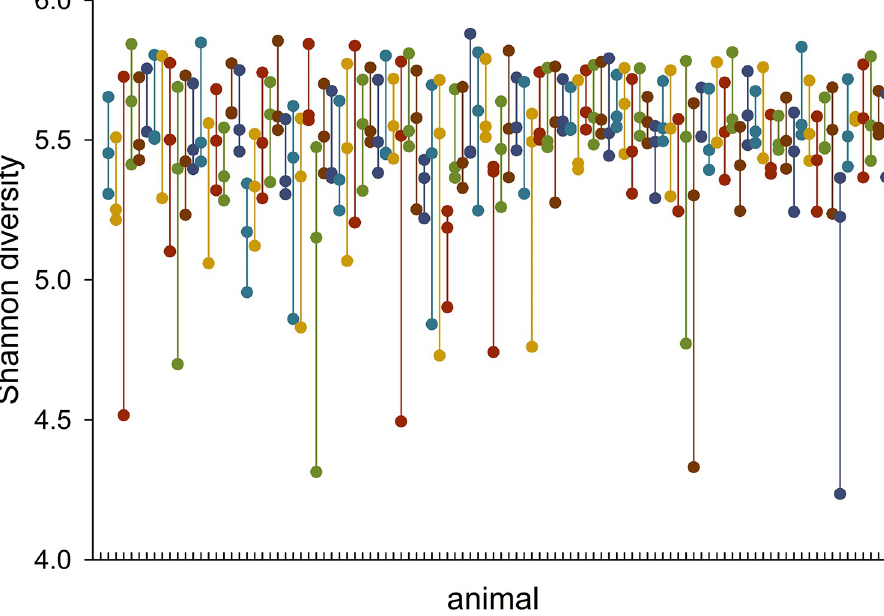
Fig 2. Persistence of low- and high-diversity microbiota over the 4-month study period. The Shannon diversity values from each animal’s microbiota are aligned vertically and connected by a line. Colors have no meaning other than improving